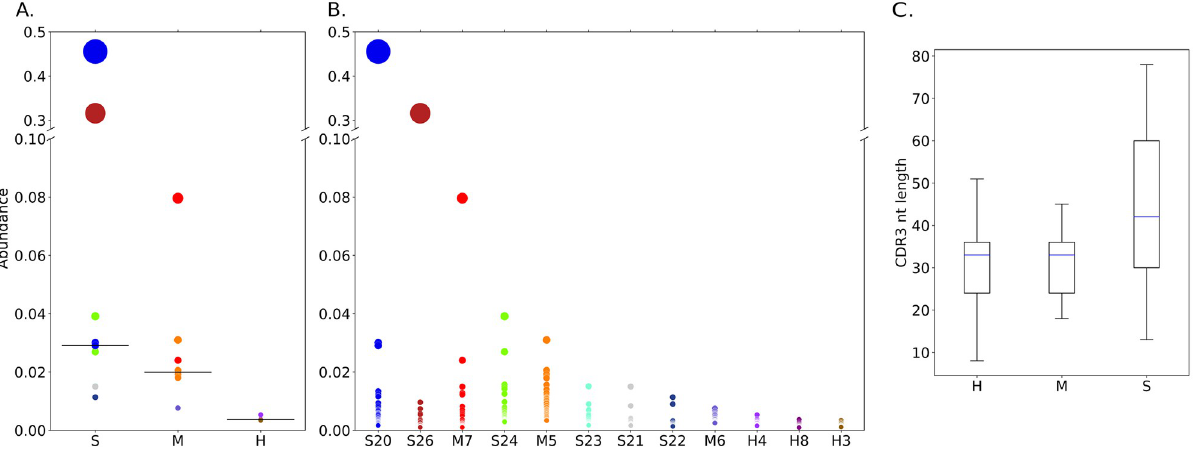
Fig 13. Clonal distribution of healthy donors and patients with moderate/severe COVID-19. A) Abundance of top 20 ranked clonal groups stratified by clinical status. We plotted each individual’s most abundant clonal groups until achieving 20 samples. B) Abundance of top 20 ranked clonal groups stratified by individuals. C) CDR3 nucleotide lengths of the top 20 clonal groups, stratified by clinical status. In panels A and B, circles represent clonal lineages, while their areas are proportional to the clonal group abundance. Each color represents an individual. Report to Table 4 for repertoire properties and individuals’ labels. Abbreviations: S-severe and M-moderate COVID-19; H-healthy donors.